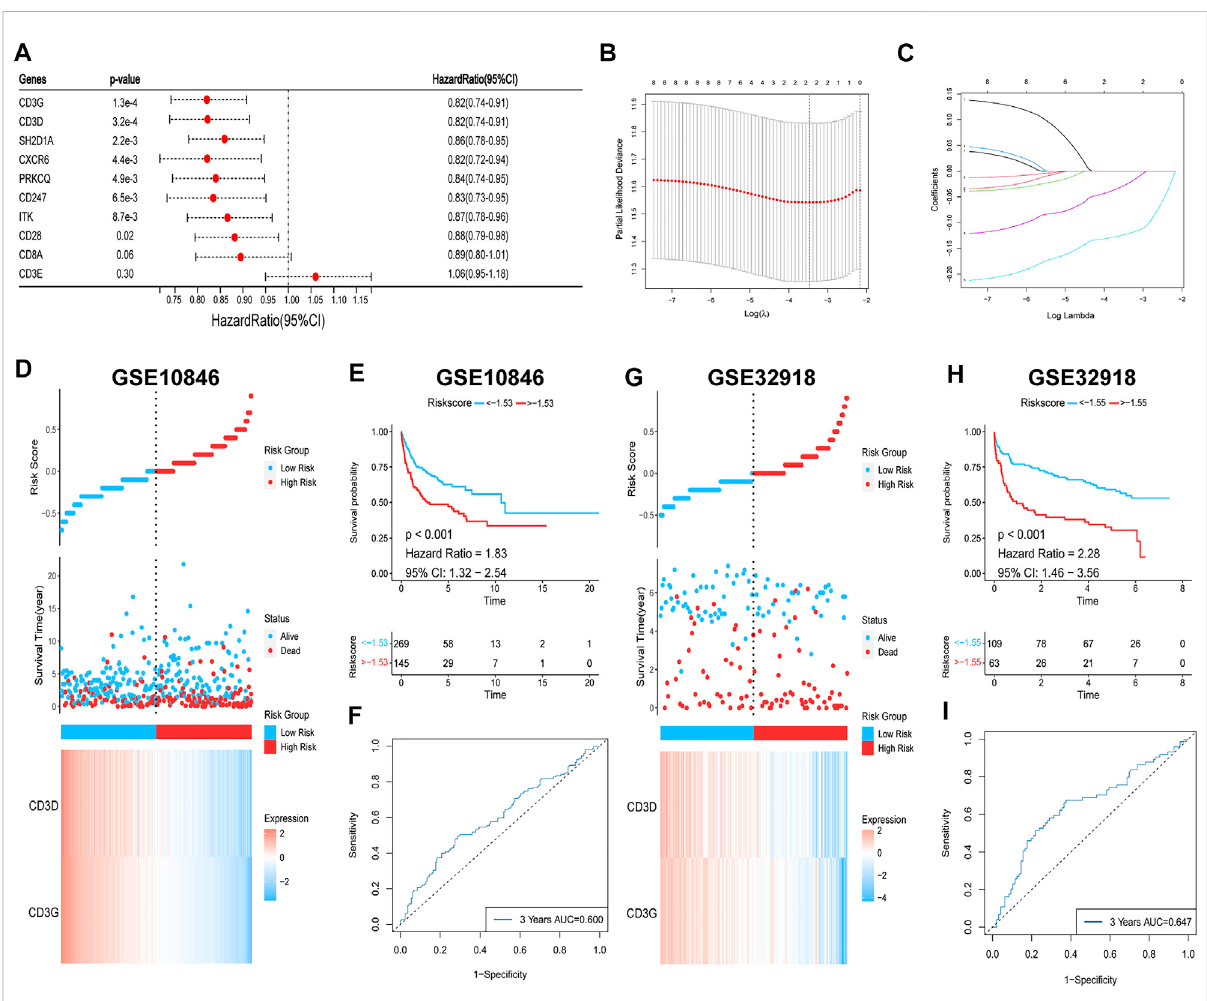
FIGURE 12 Survivalanalysisofhub genes. (A) Univariate Coxregression. (B,C) Lasso regression. (D,E)(G,H) Risk heatmaps andKaplan-Meiersurvivalcurves of riskscores. (F – I) ROC curves for predicting 3-year OS based on